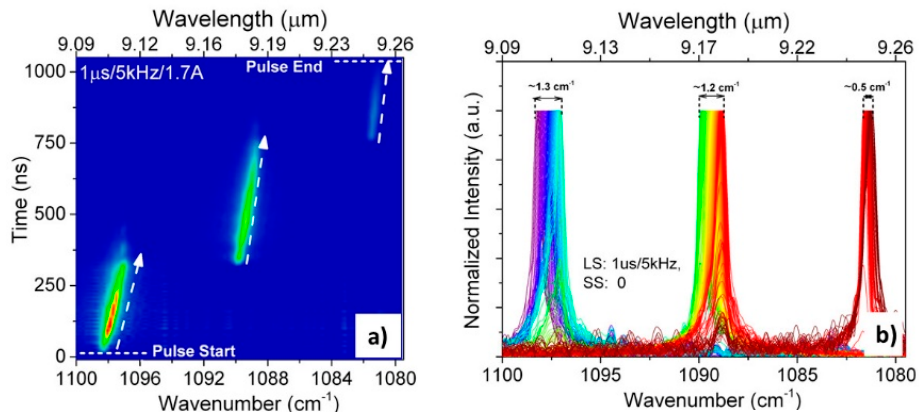
Figure 13. Time-resolved map ( a ) and normalized emission spectra extracted from the map ( b ), registered for CC-QCL operated with 1 µ s pulses at 5 kHz repetition rate.